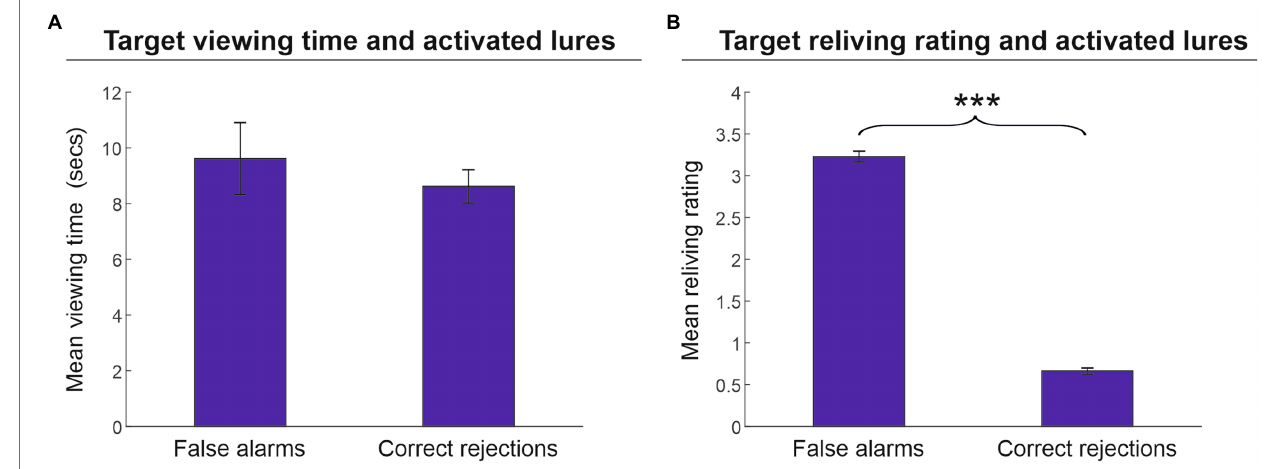
FIGURE 4 | Memory recognition performance for activated lures. Mean viewing time (A) and mean reliving rating (B) (± the standard error of the mean) in reactivated targets associated with activated lures (phase 2) that were erroneously (false alarms) or correctly recognized (correct rejections) in phase 3. Target-related viewing time did not significantly affect lure recognition outcome (A) ; by contrast, the target reliving rating was significantly higher in those lures that were erroneously recognized as artworks encountered in the tour compared to lures correctly rejected (B) . *** p <